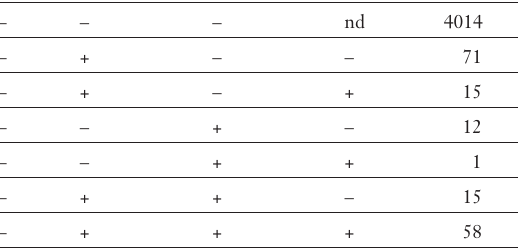
Table 3 Testing results of the 4186 donations from BTS VD; anti-HBc testing was per- formed with 2 differ- ent assays, (1) anti- HBc enzygnost from Dade Behring and (2) anti-HBc Monolisa from Biorad.